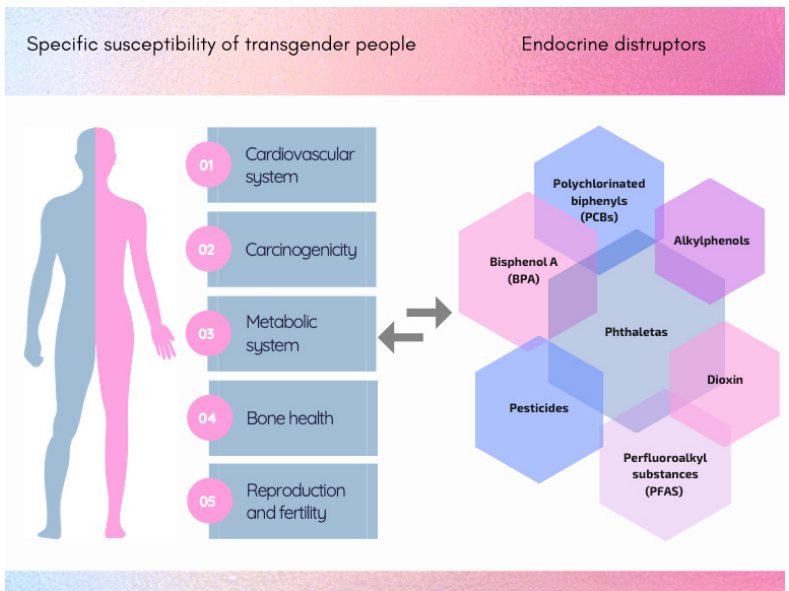
Figure 1. Schematic representation of the major systems involved in specific susceptibility of transgender men and women and its possible relationship with endocrine disruptors.